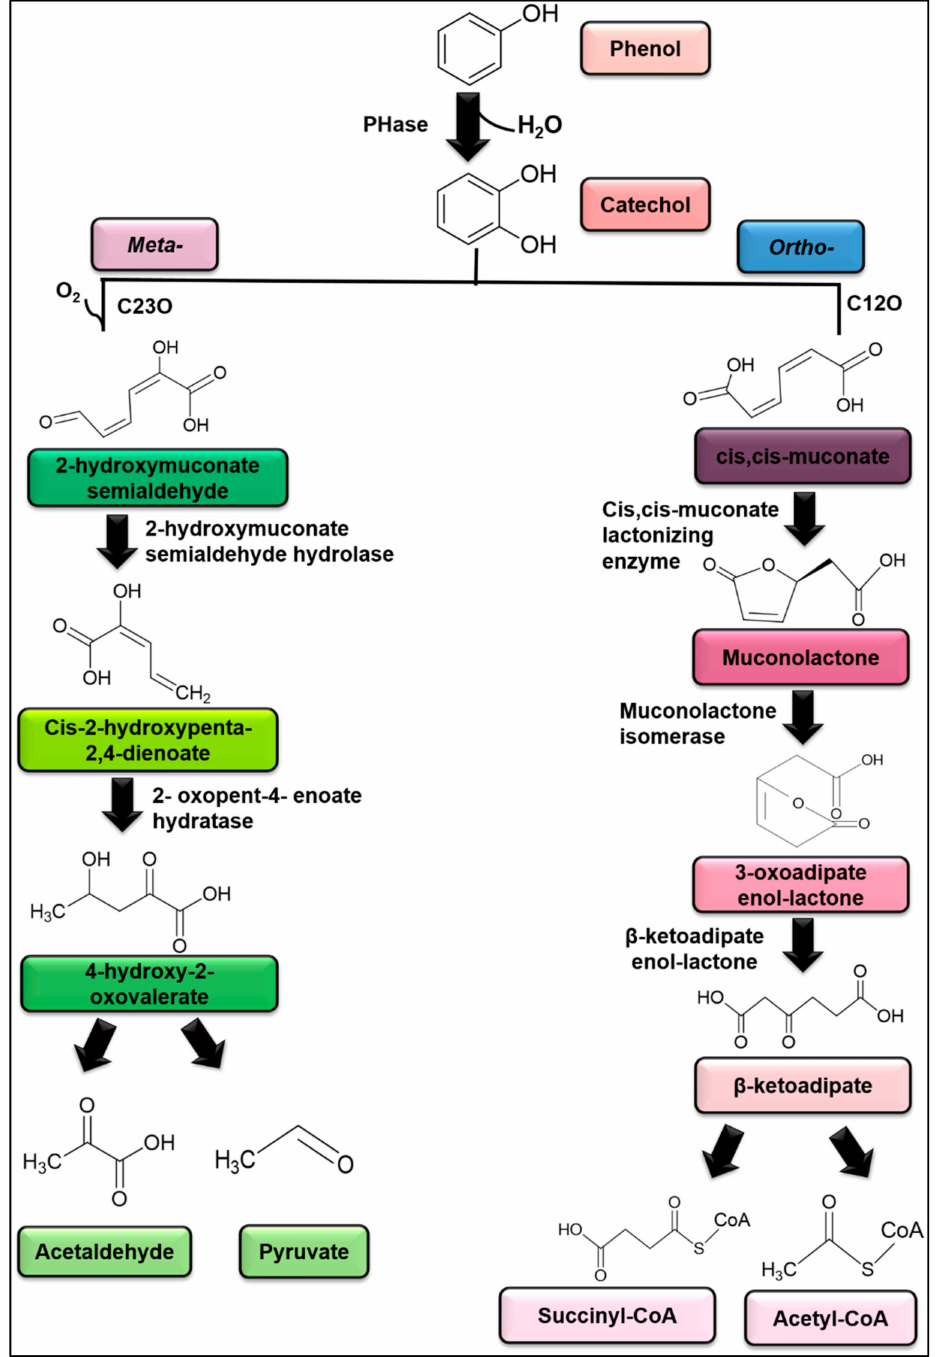
Figure 19. The proposed phenol degradation pathway by Das et al. [177]. PHase: Phenol hydroxylase; C12O: Catechol-1,2- dioxygenase; C23O: